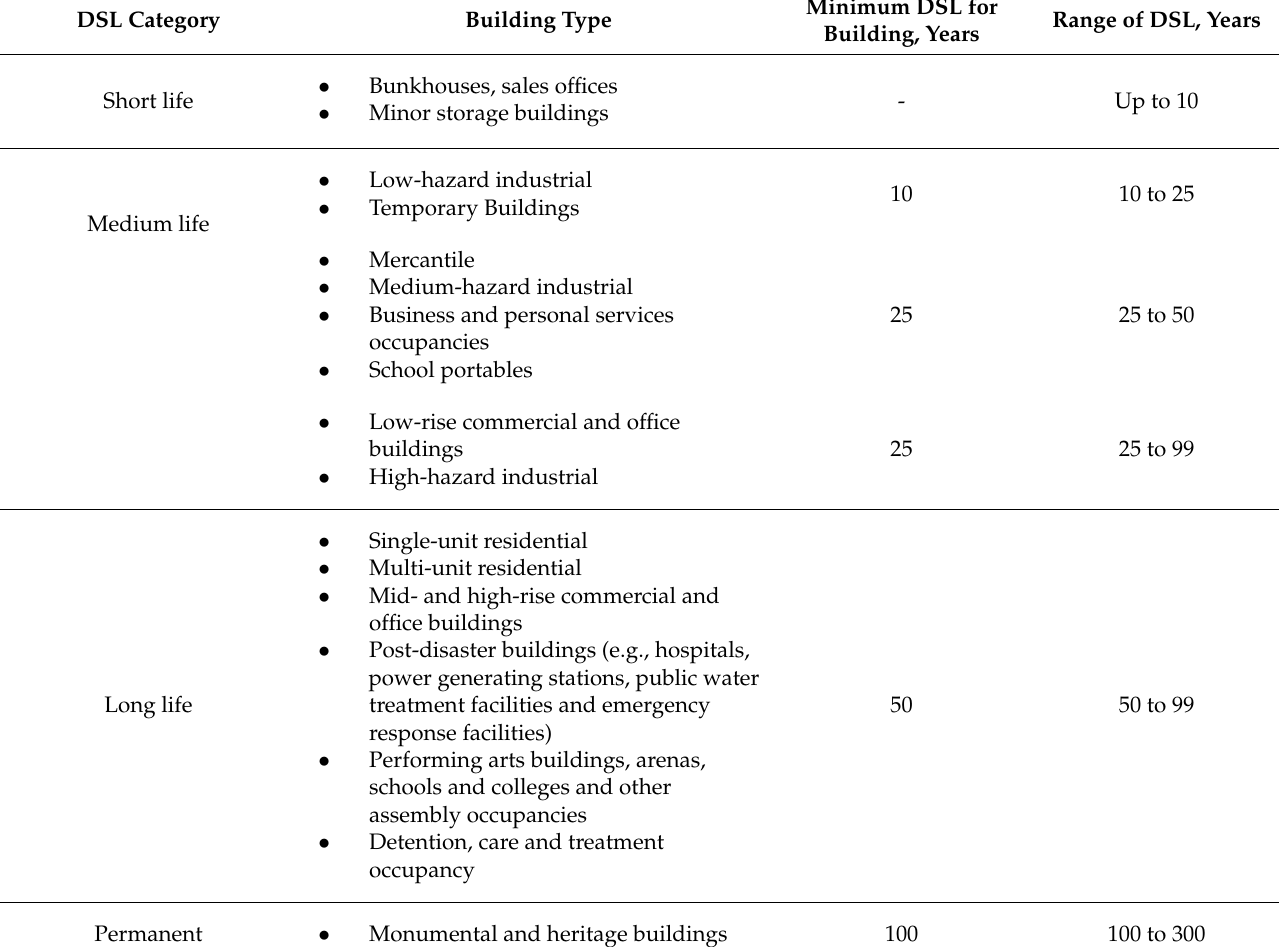
Table 5. Categories of DSL for buildings adapted from Reprinted with permission from Ref. [23]; Copyright 2019, Canadian Standards Association. DSL